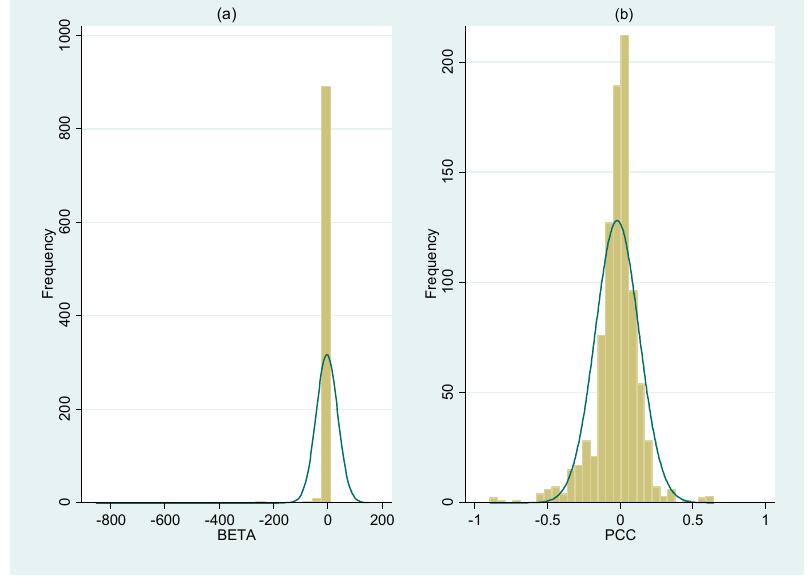
Figure 1. Distribution of the reported ( a ) and standardized effects ( b ) of bank capital on risk.